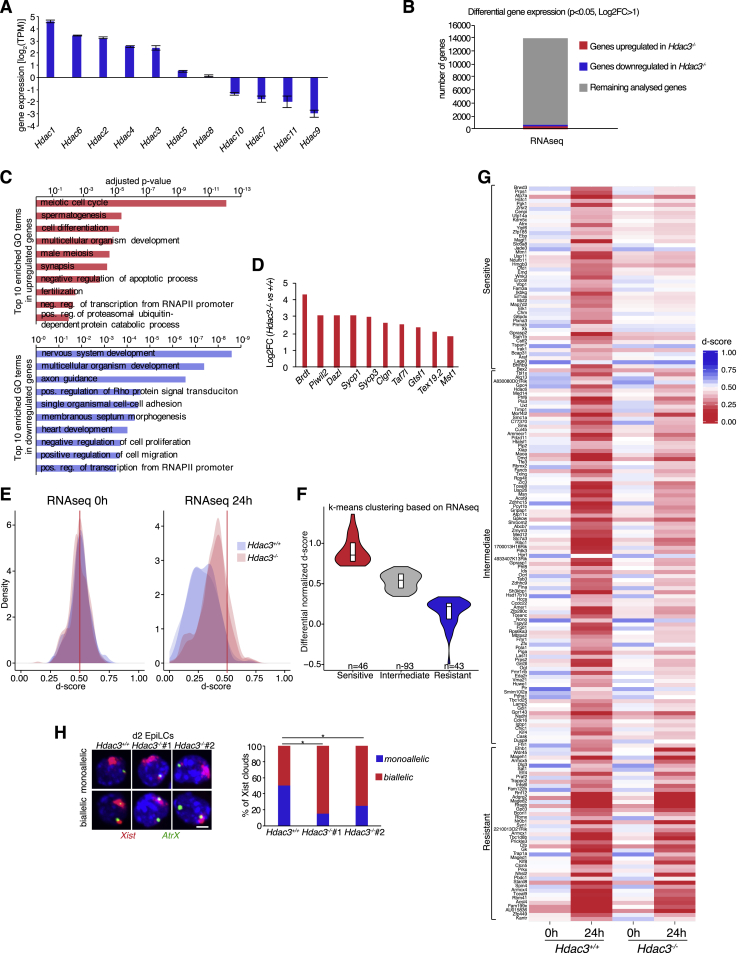
HDAC3 Mediates Efficient Trascriptional Silencing during XCI; RNA-Seq Analysis and Validation Related to Figure 3(A) Expression level of all Hdac enzymes in TX1072 ESC. Shown is average from two biological replicates (+/− StDev). (B) Plot showing the number of differentially expressed genes in Hdac3−/− cells. EdgeR p value < 0.05 and Log2FC > 1 (upregulated) or Log2FC < −1 (downregulated). Related to Table S1. (C) Top ten enriched Gene Ontology terms in upregulated (top) and downregulated genes (bottom) in Hdac3−/− cells. (D) Examples of upregulated meiosis genes in Hdac3−/− cells. Shown is average Log2FC from two biological replicates. Typically, these genes are stably repressed by DNA methylation, however here in a hypomethylated context of ESCs grown in 2i/LIF conditions, HDAC3 is responsible for suppressing their transcription. (E) Density plot representing allelic skewing of all X-linked genes after 0 and 24hrs of DOX treatment in Hdac3+/+ and Hdac3−/− lines. Data was extracted from RNA-seq results and presented is the distribution of d-scores, shown are duplicates of the control ESC line and two independent Hdac3 knockout clones. Red line shows d-score = 0.5 equating to biallelic expression. (F) Violin plot showing the distribution of normalized differential d-scores calculated from RNA-seq experiments in Hdac3+/+ and Hdac3−/− ESCs. Genes were clustered using k-means. The gene clusters are presented in a heatmap of average d-scores (G). (H) Validation of Hdac3−/− phenotype in day 2 EpiLCs induced without DOX. FISH was performed with probes for Xist (p510-Red) and an X-linked gene AtrX (Green). At least 100 nuclei with Xist clouds were imaged to assess the AtrX silencing status. ∗Chi2 p value < 0.05. Scale bar = 5 μm.